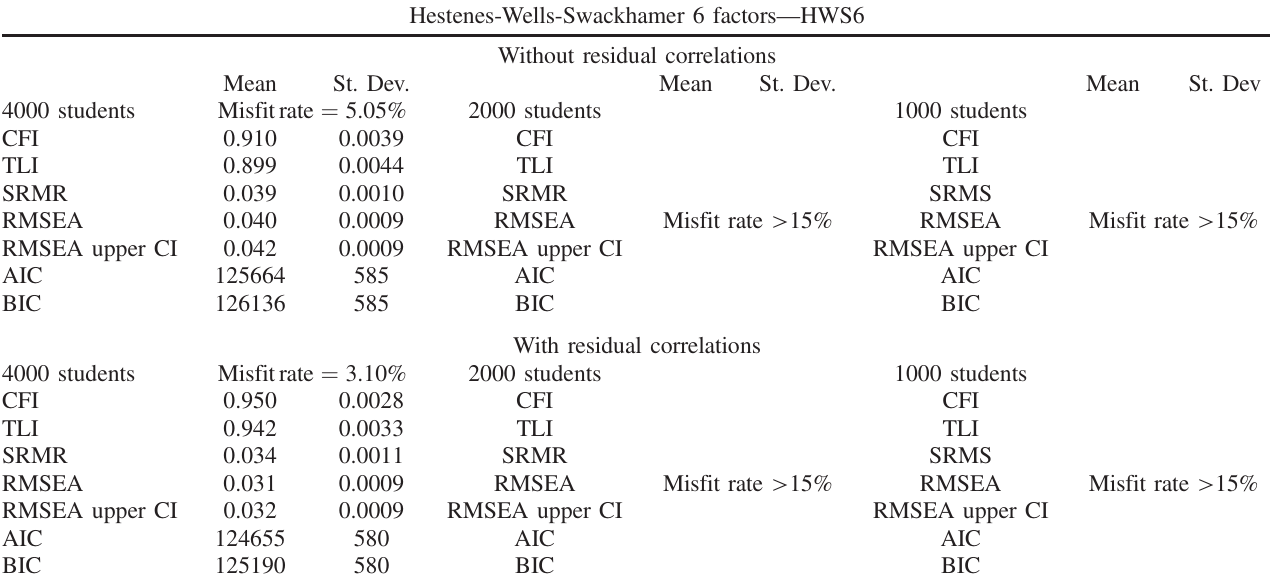
TABLE VI. Fit statistics ’ mean and standard deviations of 2000 samples of size 4000, 2000, and 1000 students for the HWS6 model. Many of the smaller samples tested misfit with the model, which is an indication that this model is not a good representation of smaller samples.